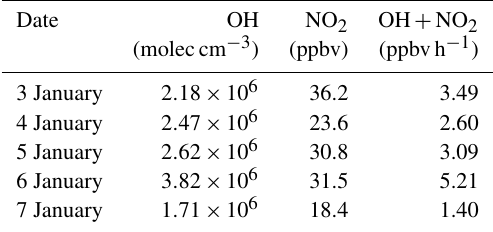
Figure 7. Comparison between the daytime (07:00 to 17:00LT; as- suming that all gas-phase HNO 3 is partitioned into particle phase) and nighttime (17:00 to 07:00LT of the next day) NO − tion potential. The early nighttime of each day represents the peri-